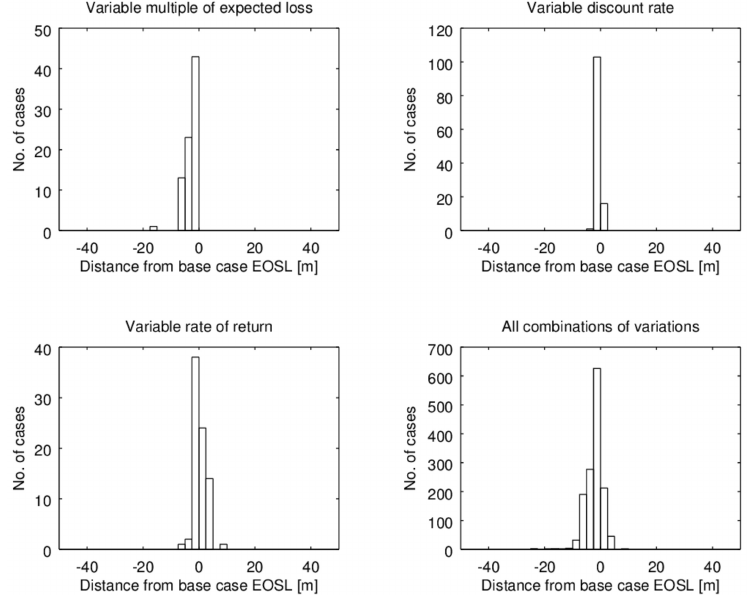
Figure 22. The distance between the EOSL based on the base case parameter values and the EOSL based on different economic constants. Results for profiles in Trincomalee, assuming they all lie in high-value zones. A negative distance implies a position seaward of the base case EOSL.